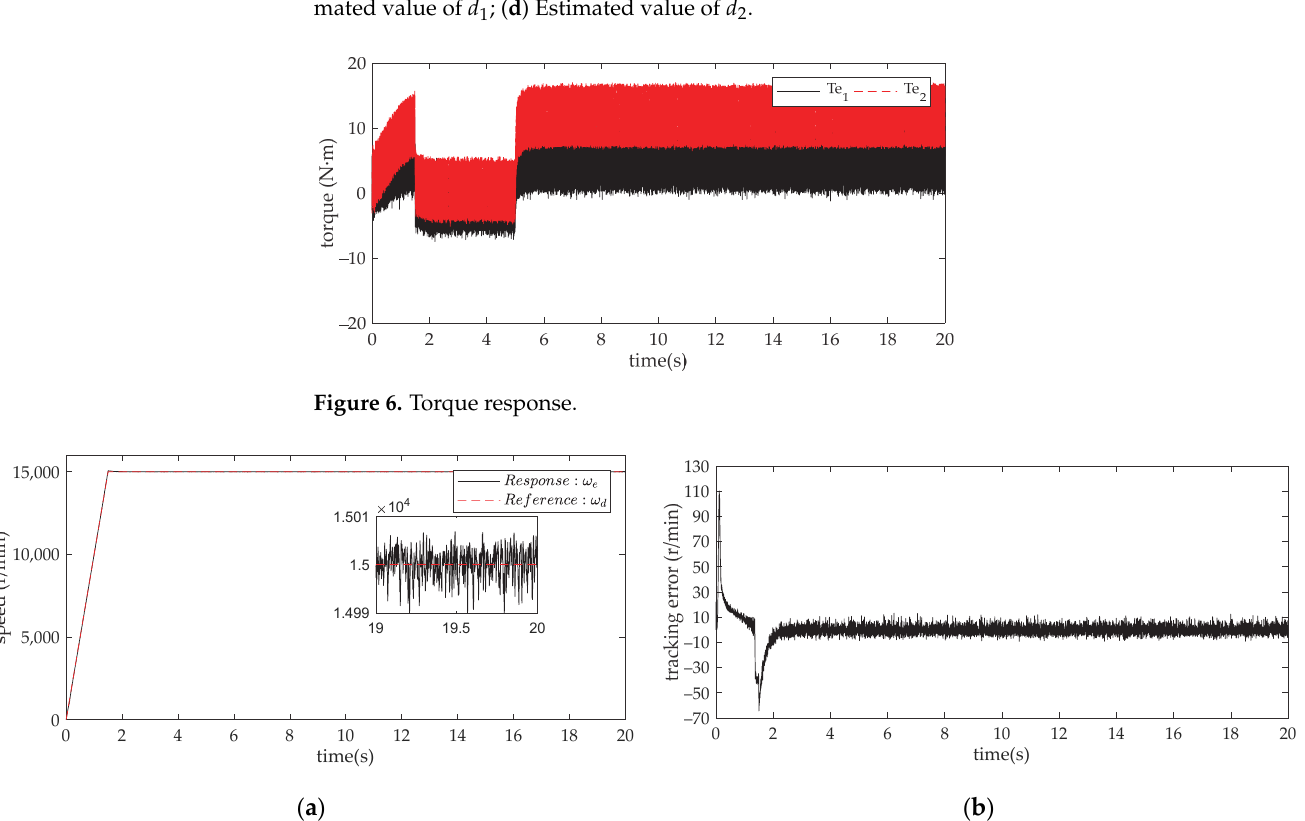
Figure 7. ( a ) Speed response under PID control; ( b ) Tracking error of PID.